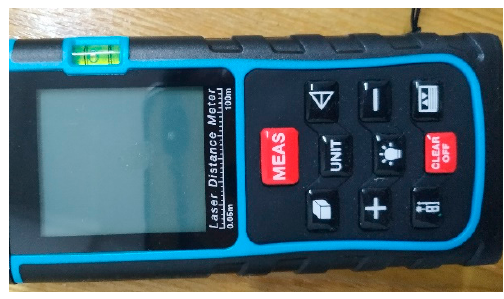
Figure 6. Laser range finder.